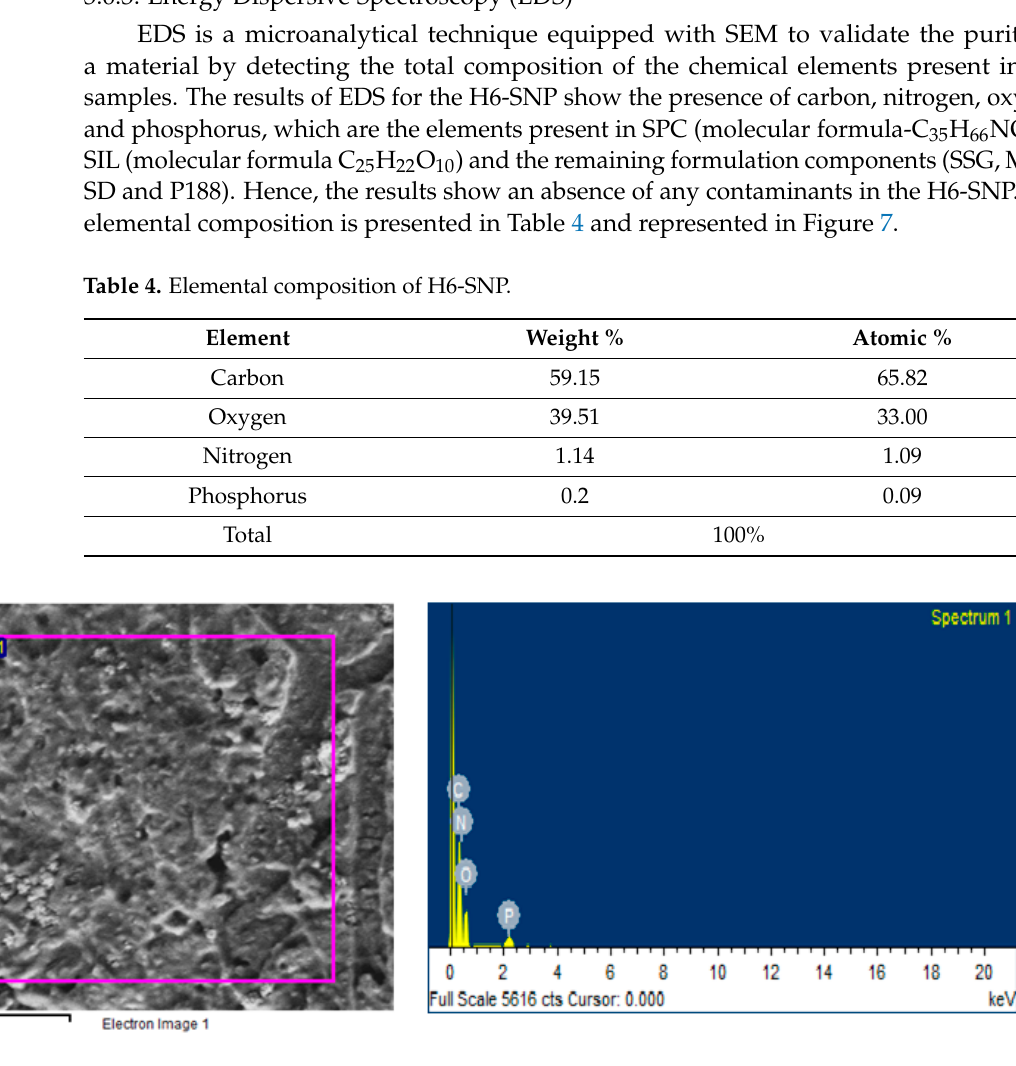
Figure 7. Elemental Mapping of H6-SNP using EDS. Table 4. Elemental composition of H6-SNP.